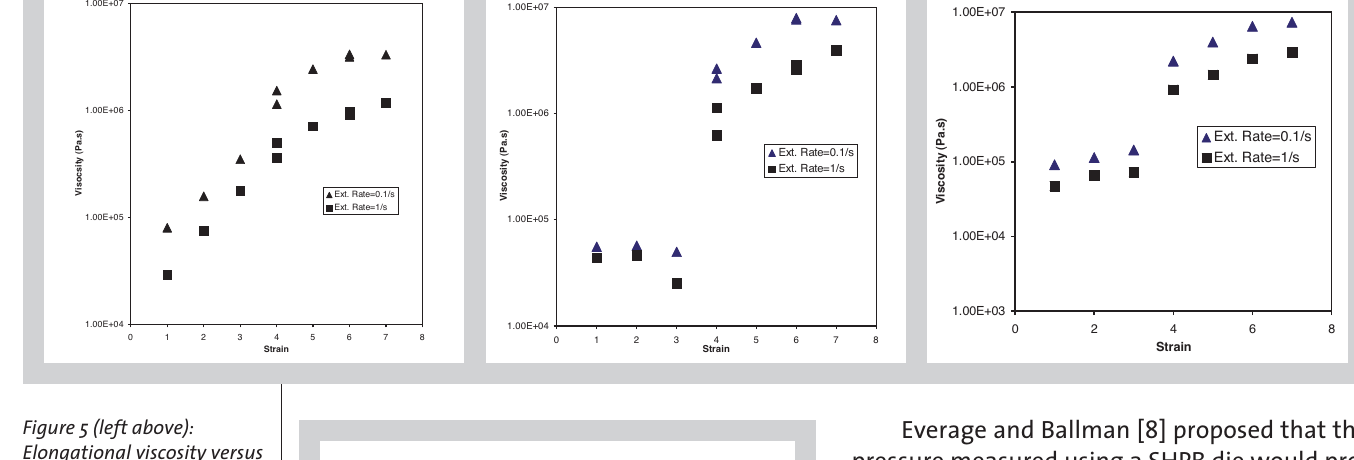
Figure 5 (left above): Elongational viscosity versus Hencky Strain for NA 952 obtained by two methods (Münstedt device strains < 3.1; SHPB die strains > 4): Ç 1.0 s -1 ; Ú 0.1 s -1 . Figure 6 (middle above): Elongational viscosity versus Hencky Strain for NTX 101 obtained by two method (Münstedt device strains < 3.1; SHPB die strains > 4): Ç 1.0 s -1 ; Á 0.1 s -1 . Figure 7 (right above): Elongational viscosity versus Hencky Strain for PL1840 obtained by two methods (Münstedt device strains < 3.1; SHPB die strains > 4): Ç 1.0 s -1 ; Ú 0.1 s -1 . Figure 8 (below): Average elongational vis- cosity calculated from data obtained from the Münst- edt device and values mea- sured by means of the semi- hyperbolic die: 1) LDPE, Ç average values, Ï semi-hyperbolic die; 2) LLDPE, Ç average values, Ú semi-hyperbolic die (Strain =